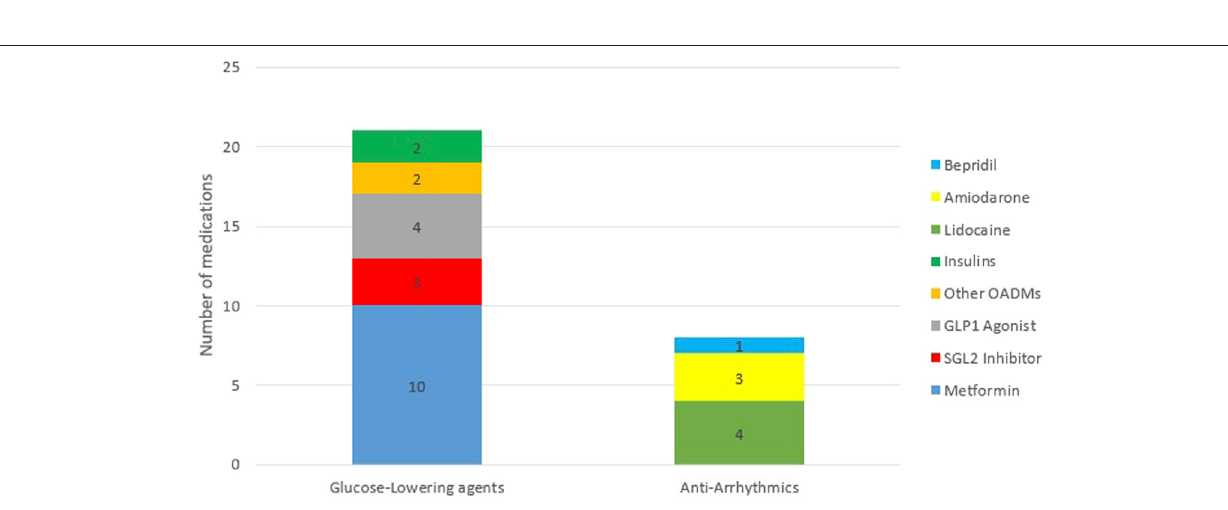
FIGURE 3 | Frequency distribution of medications. Abbreviations: OADMs, Oral Anti-diabetic Medications; GLP1 Agonist, glucagon-like peptide 1 Agonist; SGL2 Inhibitors, Sodium-glucose Cotransporter-2 Inhibitors.